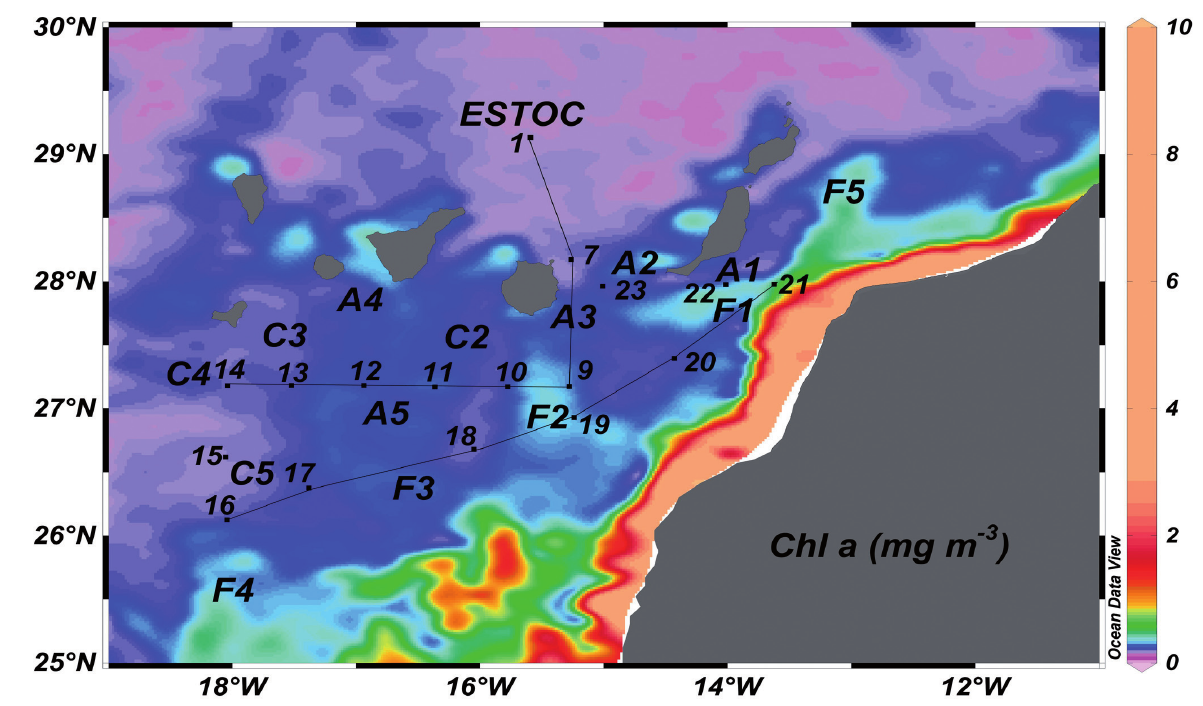
Fig . 1. – Satellite image from 19 March 2000 for the study area showing an important mesoscale structure south of the Canary Islands. Cyclonic (C) and anticyclone (A) eddy and filament (F) locations discussed in the text are labelled, as is the position of ESTOC